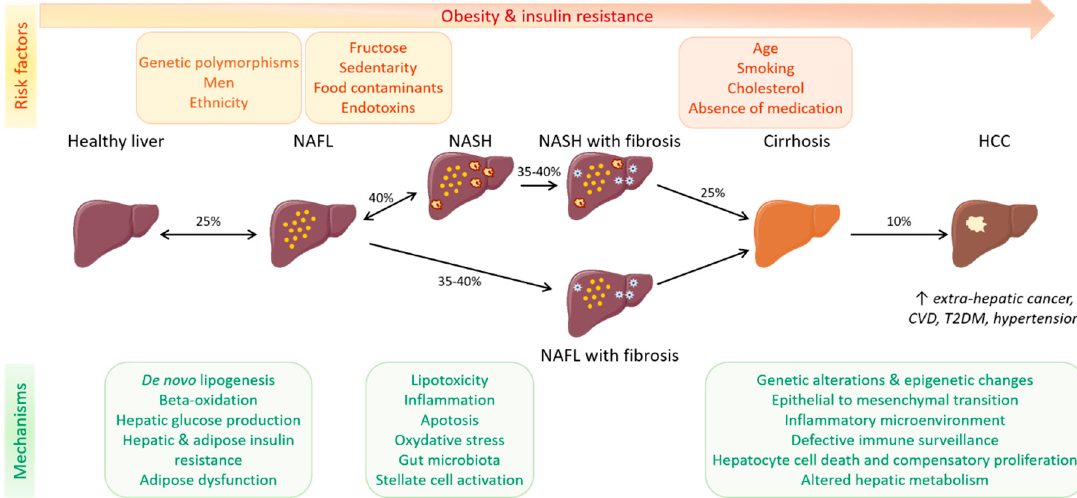
Figure 2. NAFLD progression. NAFLD is a progressive disease characterized by fat accumulation in hepatocytes, ranging from hepatic steatosis (NAFL) to non-alcoholic steatohepatitis (NASH), with additional inflammation with or without fibrosis. The latter is the strongest histological predictor of disease-related mortality. Though steatosis has previously been considered to be benign, some NAFL patients progress to NASH with or without fibrosis, whereas others develop fibrosis without having NASH. The pathogenesis of NAFLD is complex and involves several different pathways in multiple organs, including metabolic and inflammatory pathways. Abbreviations: NAFL, non-alcoholic fatty liver; NASH, non-alcoholic steatohepatitis; HCC, hepatocellular carcinoma; T2DM, type 2 diabetes mellitus; CVD, cardiovascular disease.